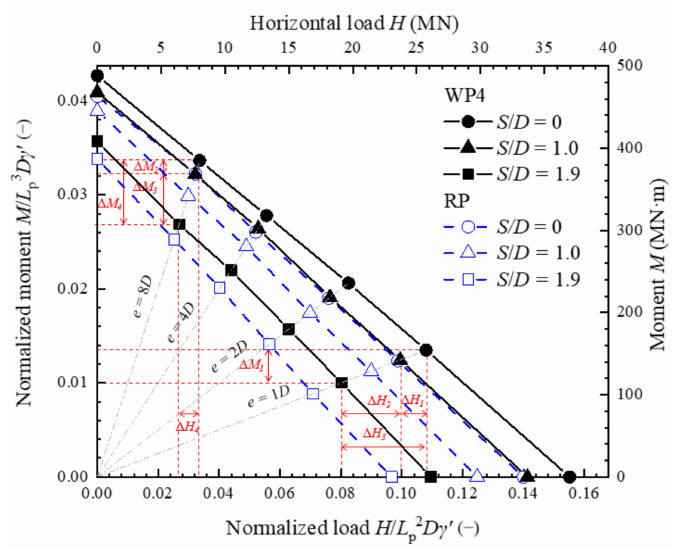
Figure 15. Moment–lateral load interaction diagram at